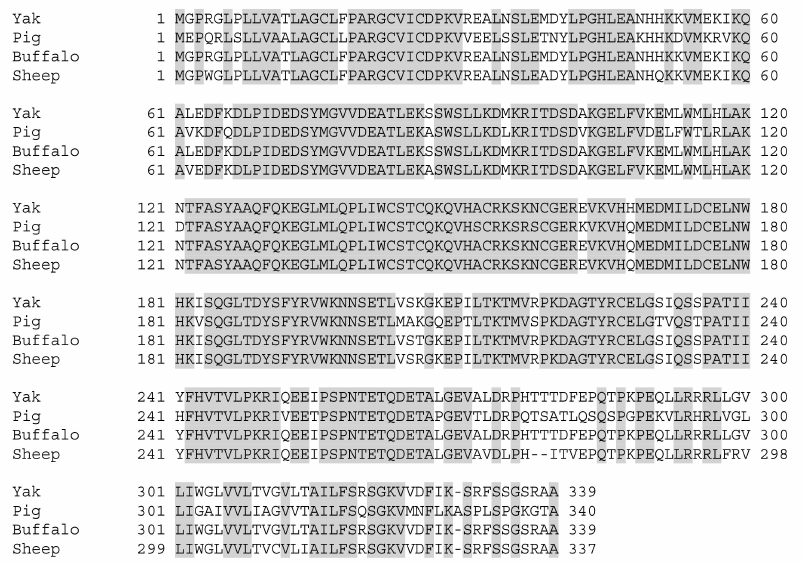
Figure 5. Multiple alignment of amino acid sequences of yak IZUMO1 protein with pig, bu ff alo, and sheep IZUMO1. Identical amino-acids are represented by shaded